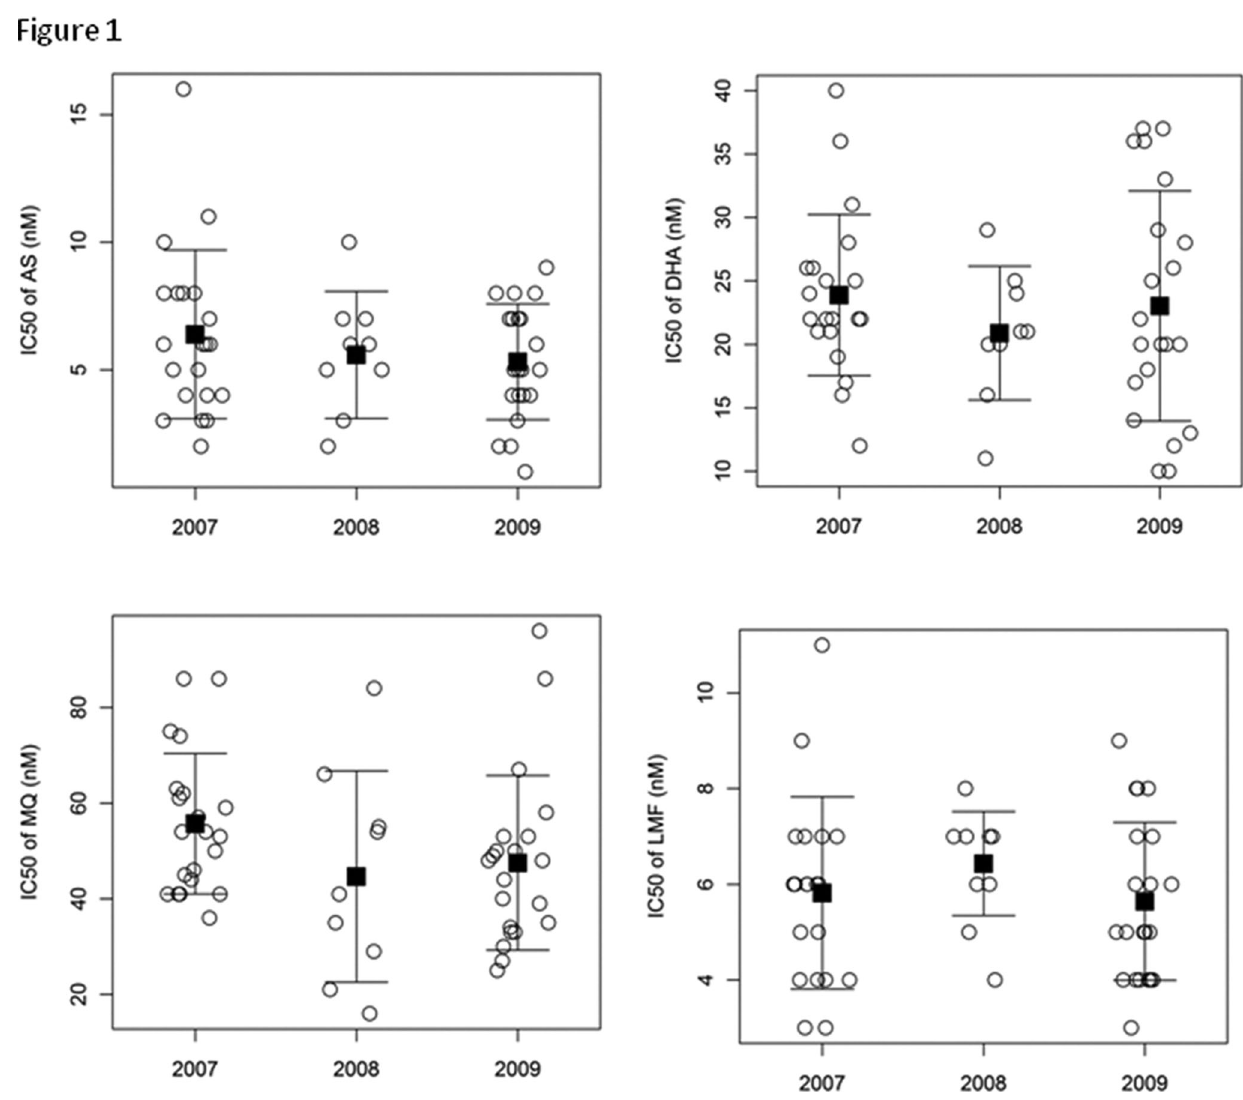
Figure 1. Invitro drug responses. IC50s (nM) of P. falciparum isolates to artesunate (AS), dihydroartemisinin (DHA), mefloquine (MQ) and lumefantrine (LMF) are stratified by year. Solid boxes ( & ) indicate the mean values; the error bars denote one standard deviation. For IC 50 values of each drug, there was no significant differences between the years ( P . 0.05, t- test).